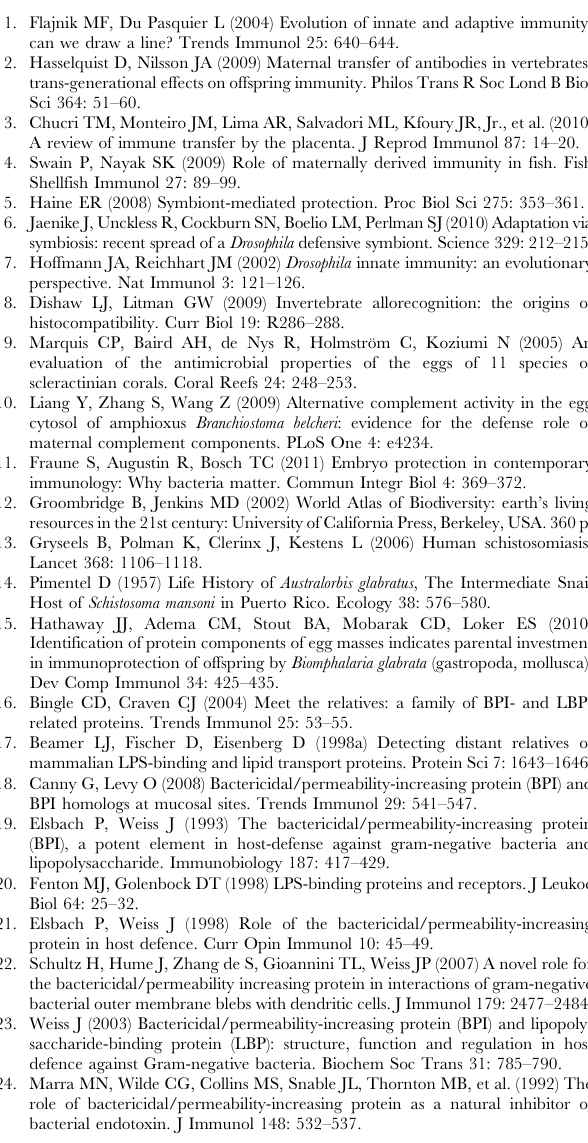
percentages of three independent experiments (Mantel-Cox log- rank test, Software Prism v.5.0, GraphPad). Figure S3 rBgLBP/BPI1 does not show a significant effect on the viability of various micro-organisms. Survival rate of various Gram-positive, gram-negative bacteria or fungi after exposure to rBgLBP/BPI1 (A) or hBPI (B) at 100 m g/ml. Results are mean percentages ( 6 SE) of three independent experiments. Figure S4 BgLBP/BPI1s and hBPI display anti-oomycete activity against P. parasitica zoospores. (A) P. parasitica developmental stages, namely (a) zoospores, (b) cysts and (c) microcolonies. (B) Representative pictures of the anti-oomycete effect of (a) BSA, (b) hBPI, (c) rBgLBP/BPI1 and (d) nBgLBP/BPI1 at 30 m g/ml on P. parasitica zoospores. Pictures were taken after 30 min of incubation. Scale bars represent 20 m m.